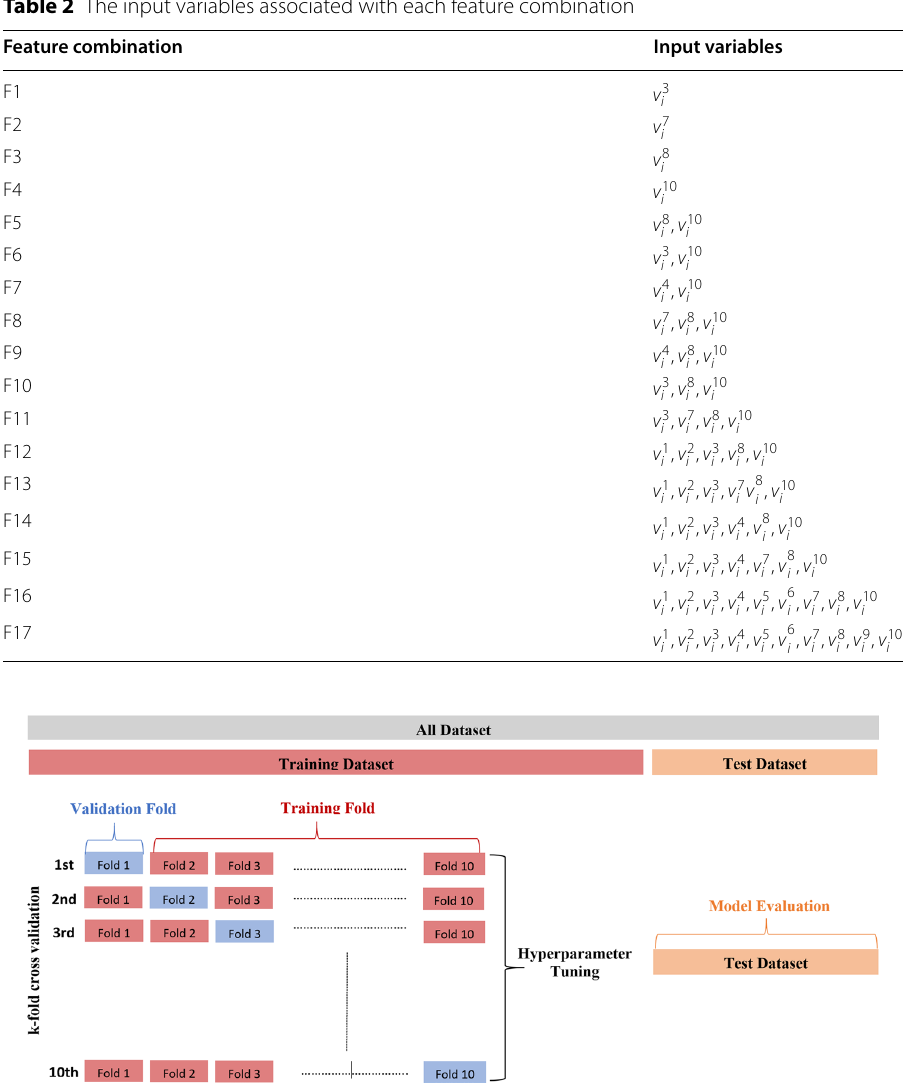
Fig. 4 k -fold Cross-Validation